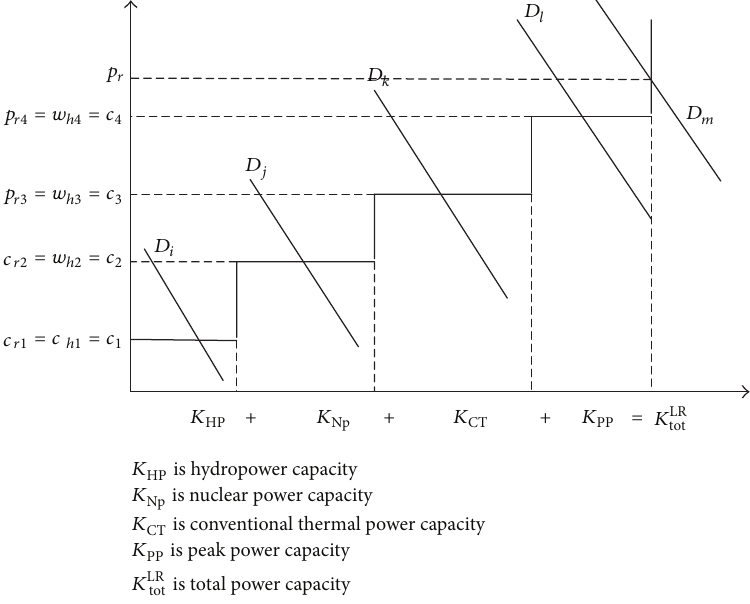
Figure 4: The long-run structure of the energy